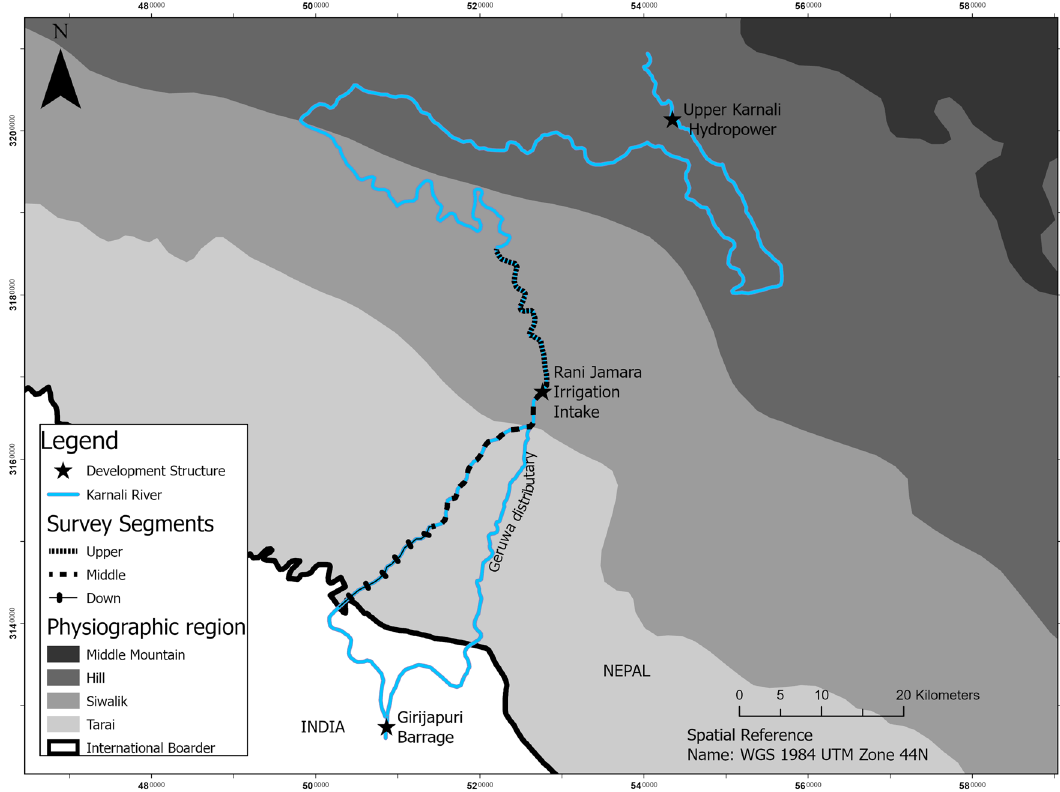
Figure 1. Map of the Karnali River system of Nepal showing locations of Upper Karnali Hydropower, Rani Jamara Kulariya Irrigation Intake and Girirajpuri Dam (in India) that extract the water from the mainstream Karnali River. Survey segments (S1, S2 and S3) represent the historically and presently occupied potential habitat of the Ganges River dolphins. The map was prepared using ArcGIS Pro 2.6 (Esri Inc.; www.pro.arcgi s.com), and data (physiographic and river) developed by the Government of Nepal were used to prepare this